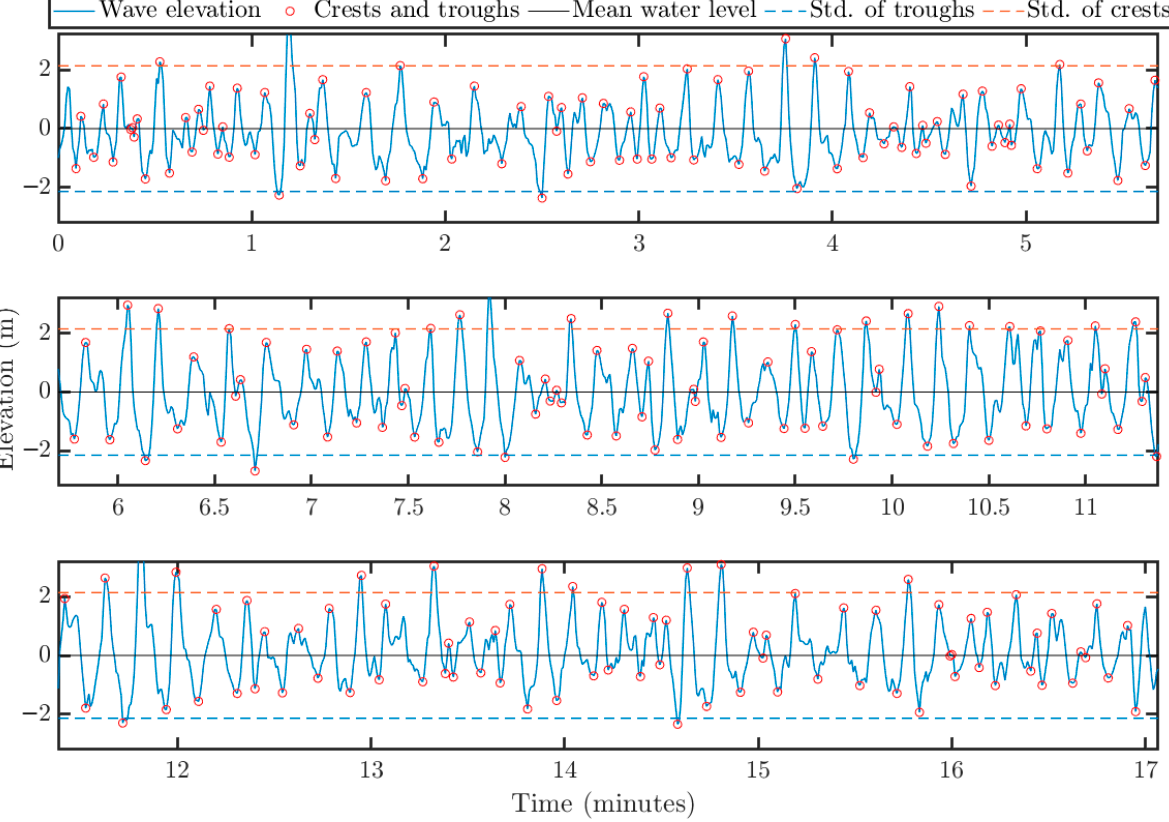
Figure 7. Time history of the measured wave height.